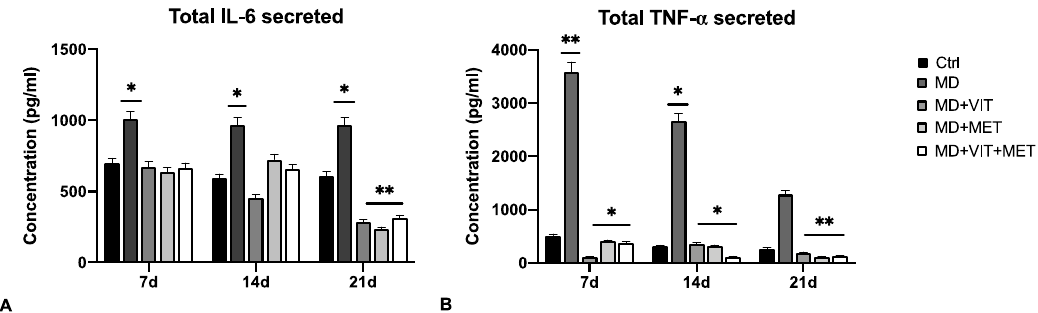
Figure 3. IL-6 and TNF- α quantification by ELISA: The concentration of IL-6 ( A ) and TNF- α ( B ) was measured after 7, 14, and 21 days in supernatants of ADSCs cultured in the presence of adipogenic differentiation medium (MD) (blue bars), or in MD plus vitamin D (MD+VIT) (yellow bars), or in MD plus metformin (MD+MET) (orange bars), or in MD with both metformin and vitamin D (MD+VIT+MET) (red bars), as compared to control untreated cells (grey bars). Data are expressed as mean ± SD referred to the control (mean ± SD; n = 6) (* p ≤ 0.05; ** p ≤ 0.01).